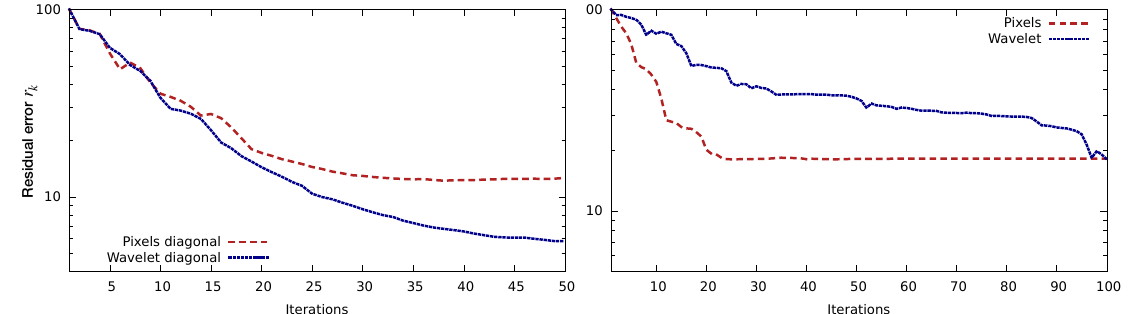
Figure 9. Ratio of the residual errors as a function of minimisation iterations for both wavelet and pixel methods, in the presence of correlated observation errors. ( Left ) homogeneously correlated error, ( right ) inhomogeneously correlated